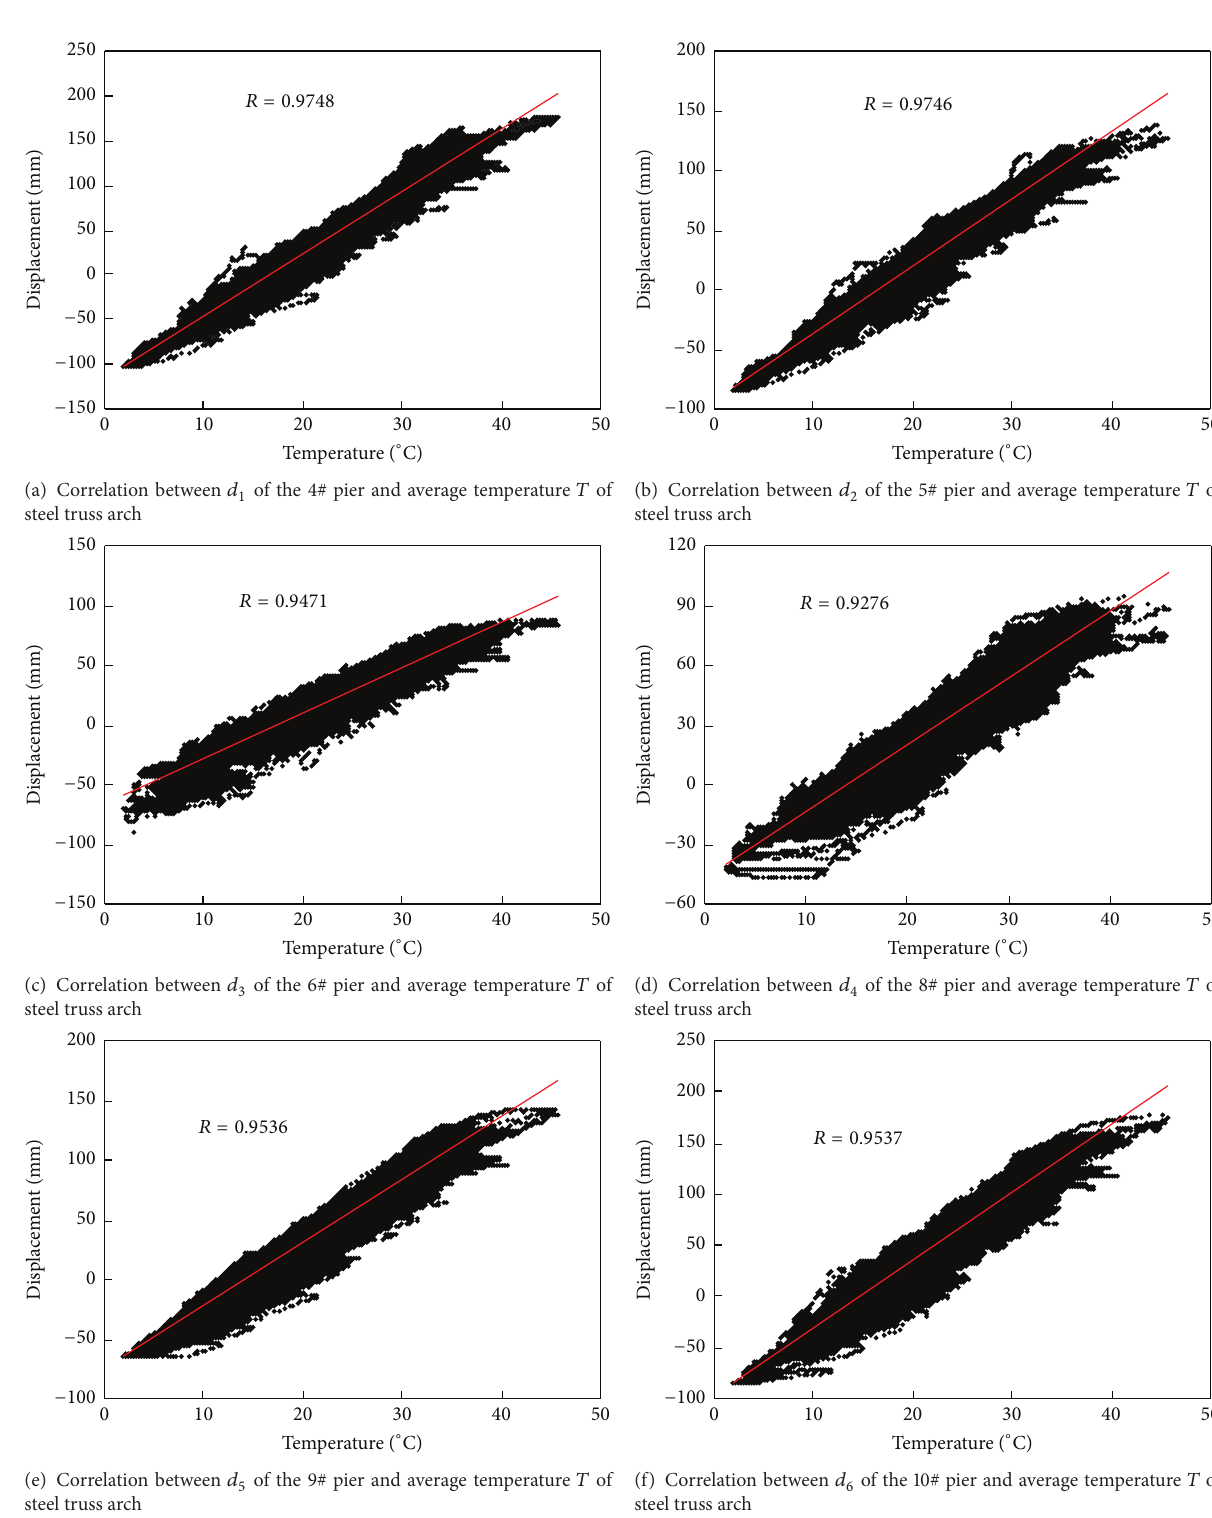
Figure 18: Correlation between longitudinal displacement and average